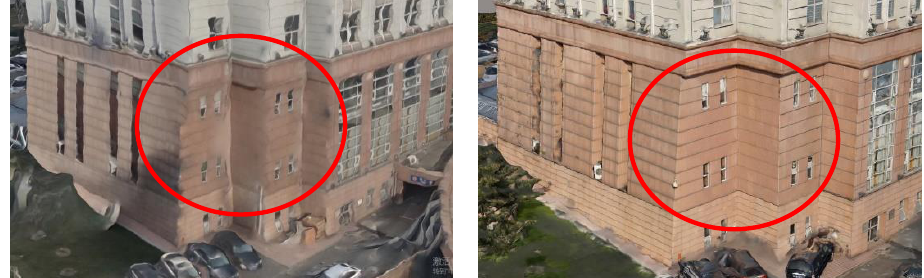
Figure. 11 The side of one building model produced by oblique photogrammetry(OP) only(left) and produced by OP and